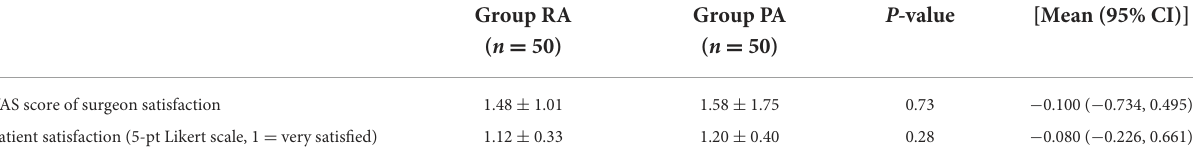
TABLE 5 Comparison of the sedation satisfaction survey between the two